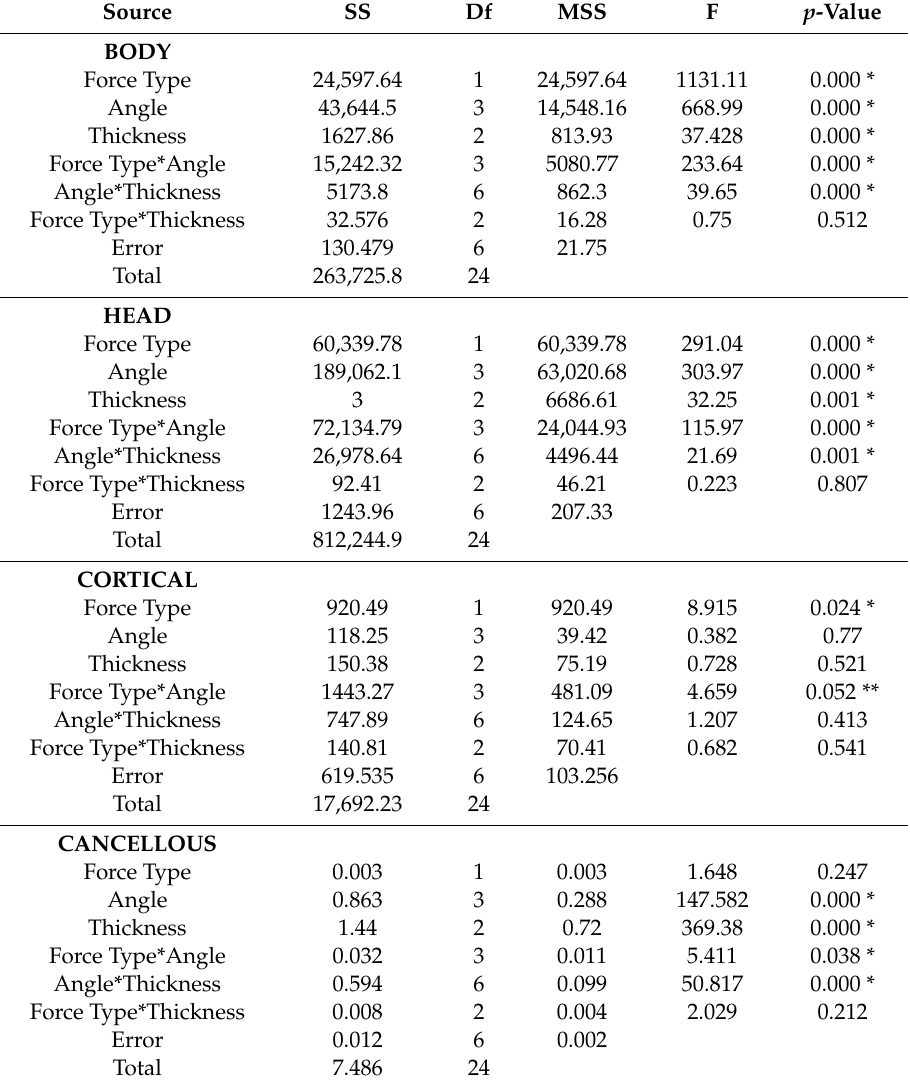
Table 2. ANOVA results of the von Mises stress level on the implant and